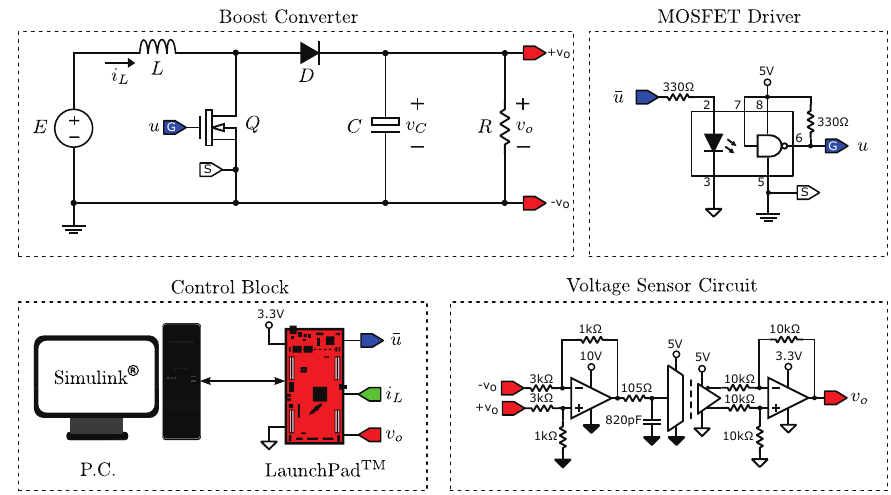
Figure 9. Schematic diagram of the experimental platform.